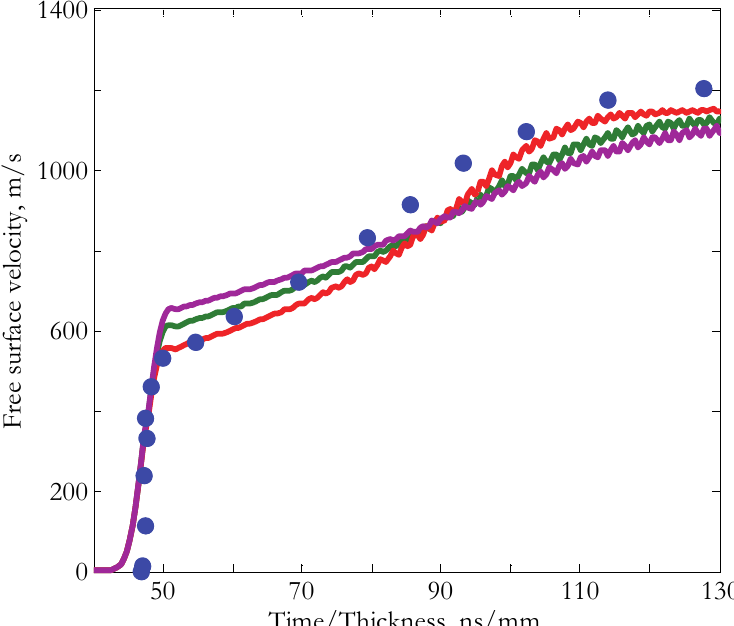
Figure 7: Free surface velocity profiles for silicon carbide samples in normalized time coordinates: ○ − experiment [15], lines − numerical simulation for different target thicknesses (8.32 mm, 3.81 mm, 2.15 mm)